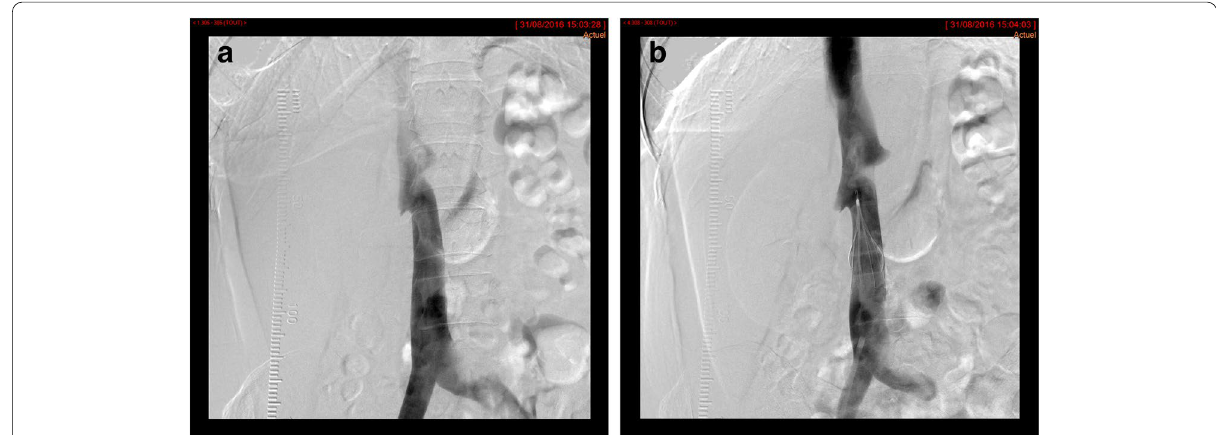
Fig. 2 Anteroposterior angiography of the inferior vena cava before ( a ) and after filter implantation ( b ) for a 65 years old woman with current PE and DVT contra-indicated to anticoagulant therapy because of scheduled gynecological surgery (ovarian cancer). The angiography showed a fully